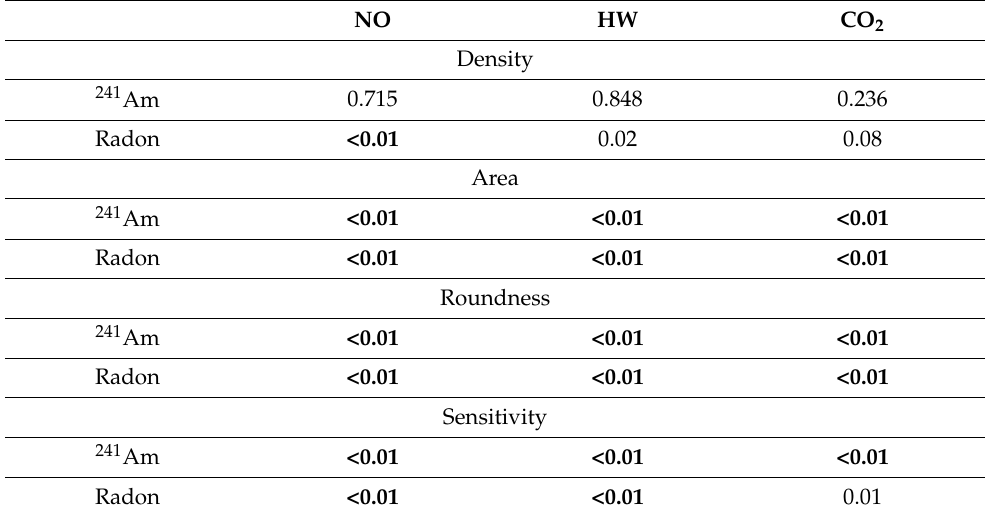
Table 13. One-way ANOVA of track density for etching time effect with fixed pre-etching